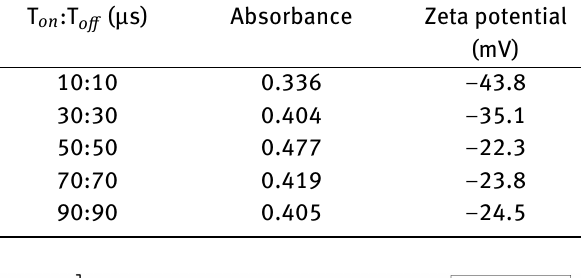
Table 2: Absorbance and zeta potential of different T on :T off T on :T off ( µ s)